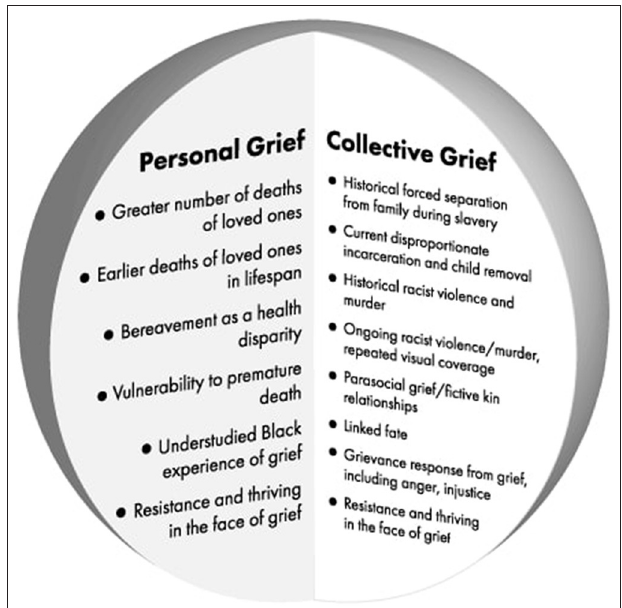
FIGURE 1 | Examples constituting personal and collective grief axes of Black